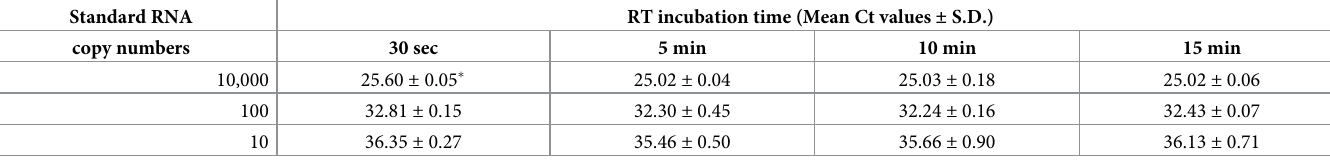
Table 4. The effect of RT incubation time and standard RNA copy numbers on the Ct values of the one-step RT-PCR with MM4 and M1pol Tth . Standard RNA RT incubation time (Mean Ct values ±